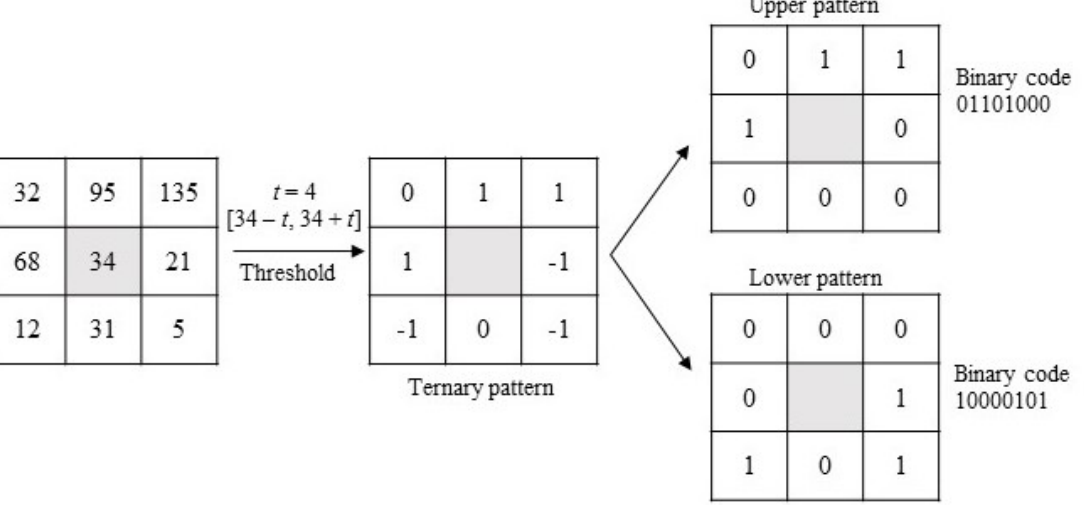
Figure 3. Graphic example of the LTP